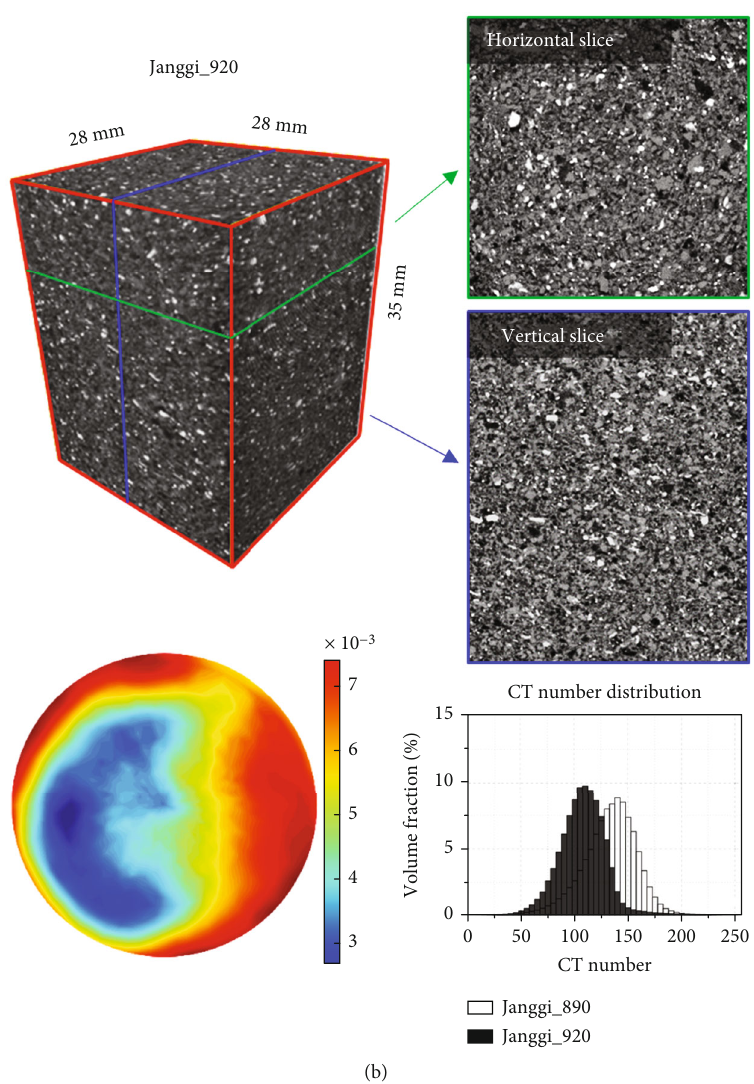
Figure 6: Internal con fi guration and SPM results from X-ray CT images of Janggi Basin rocks extracted from depths at (a) 890 m and (b) 920m. The bedding plane appears to be existed in Janggi_890 with an inclination of 30 o